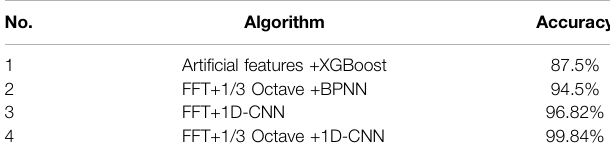
TABLE 1 | 1D-CNN algorithm and other algorithms accuracy comparison table.